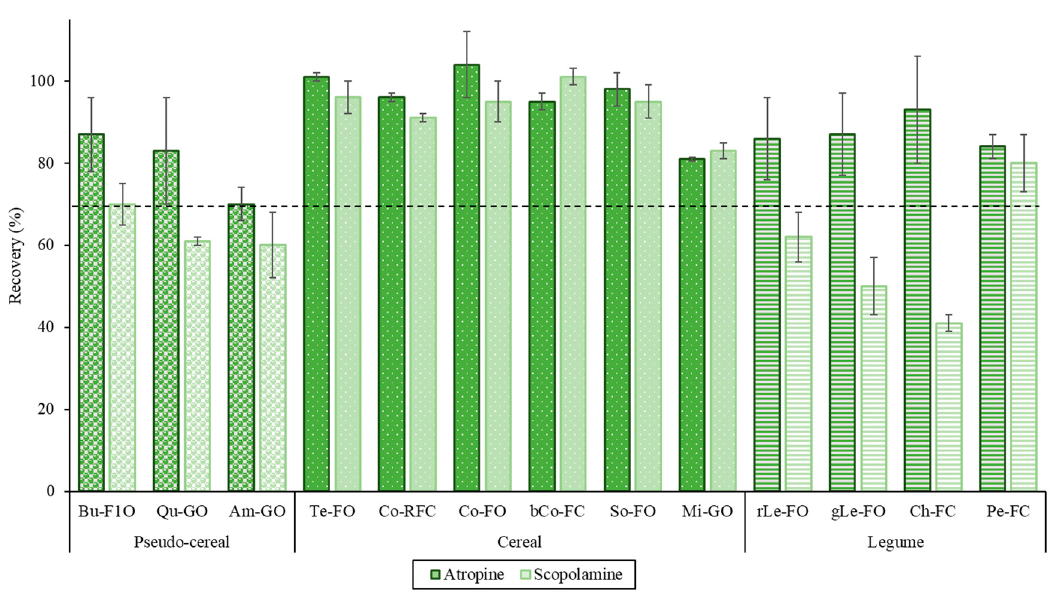
Figure 4. Recovery percentage for atropine and scopolamine in gluten-free (GF) grains and flours under optimized SLE-SPE conditions.